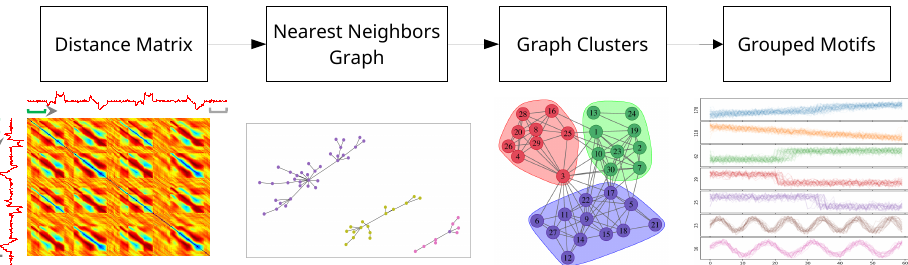
Figure 1. Flowchart of processing steps for unsupervised motif selection. First Image Source: Modified from Mueen & Eamonn [37]. Third Image Source: Modified from Ferreira & Zhao